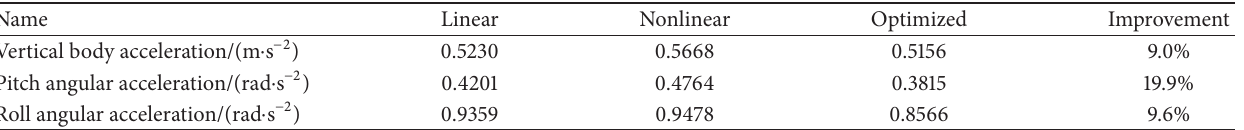
Table 4: Performance